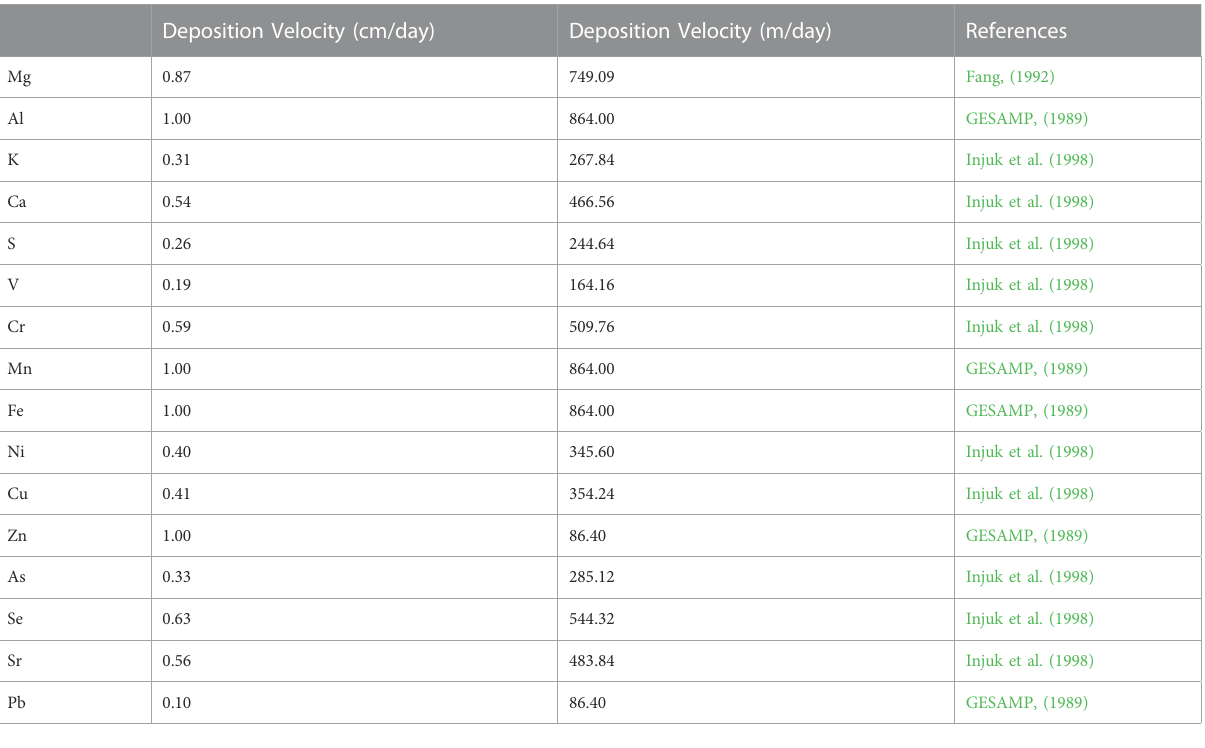
TABLE 1 Settling velocities of PM elements from the literature.